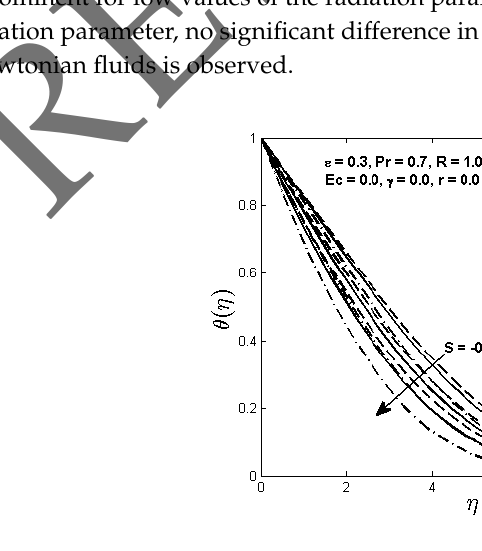
Figure 4. Temperature profiles for various values of S and n